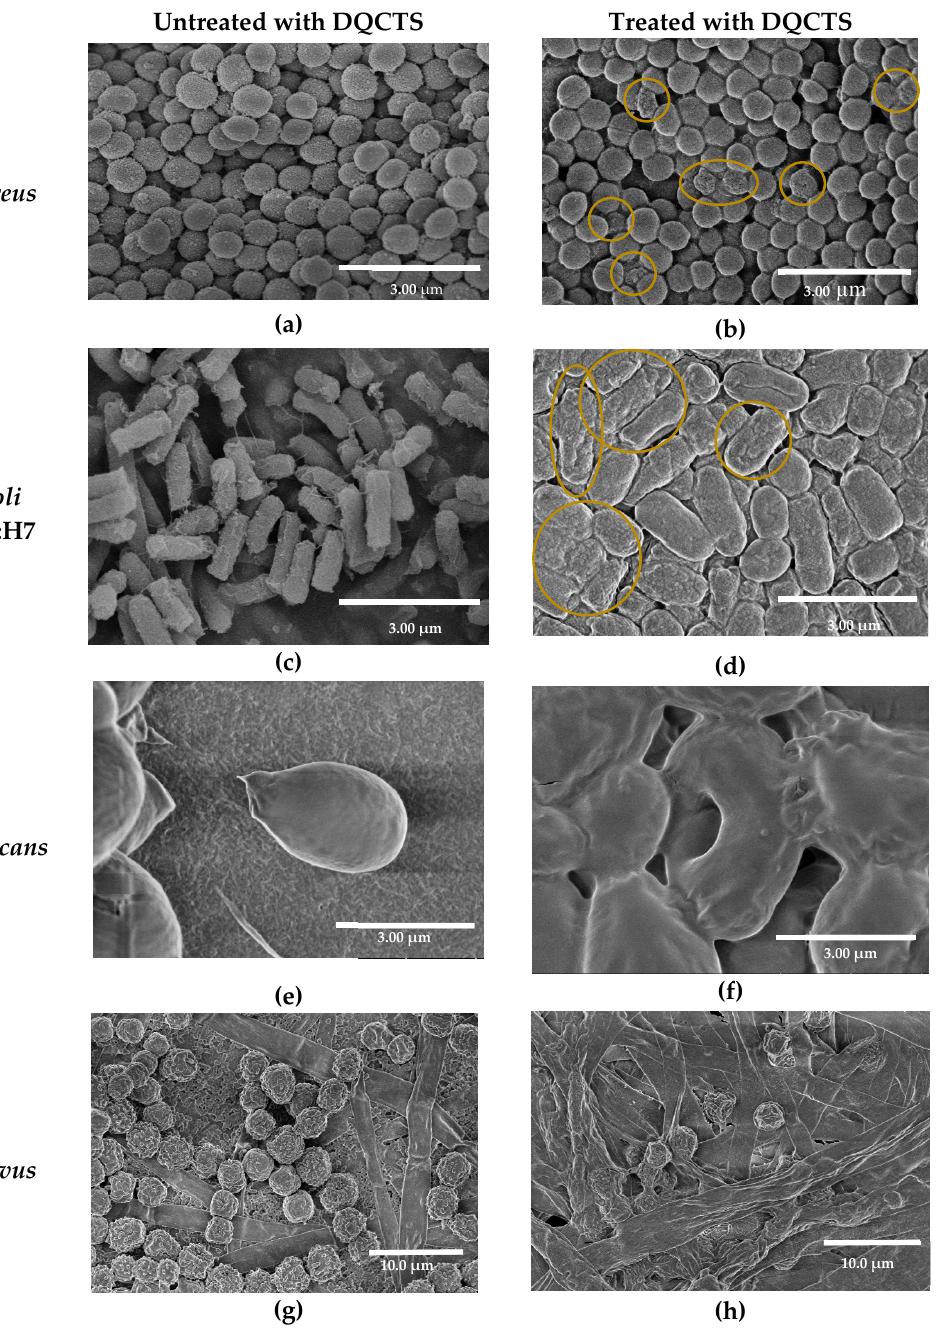
Figure 3. FE-SEM images of microorganisms before ( a , c , e , g ) and after treatment ( b , d , f , h ) with fully deacetylated quaternized chitosan (DQCTS).